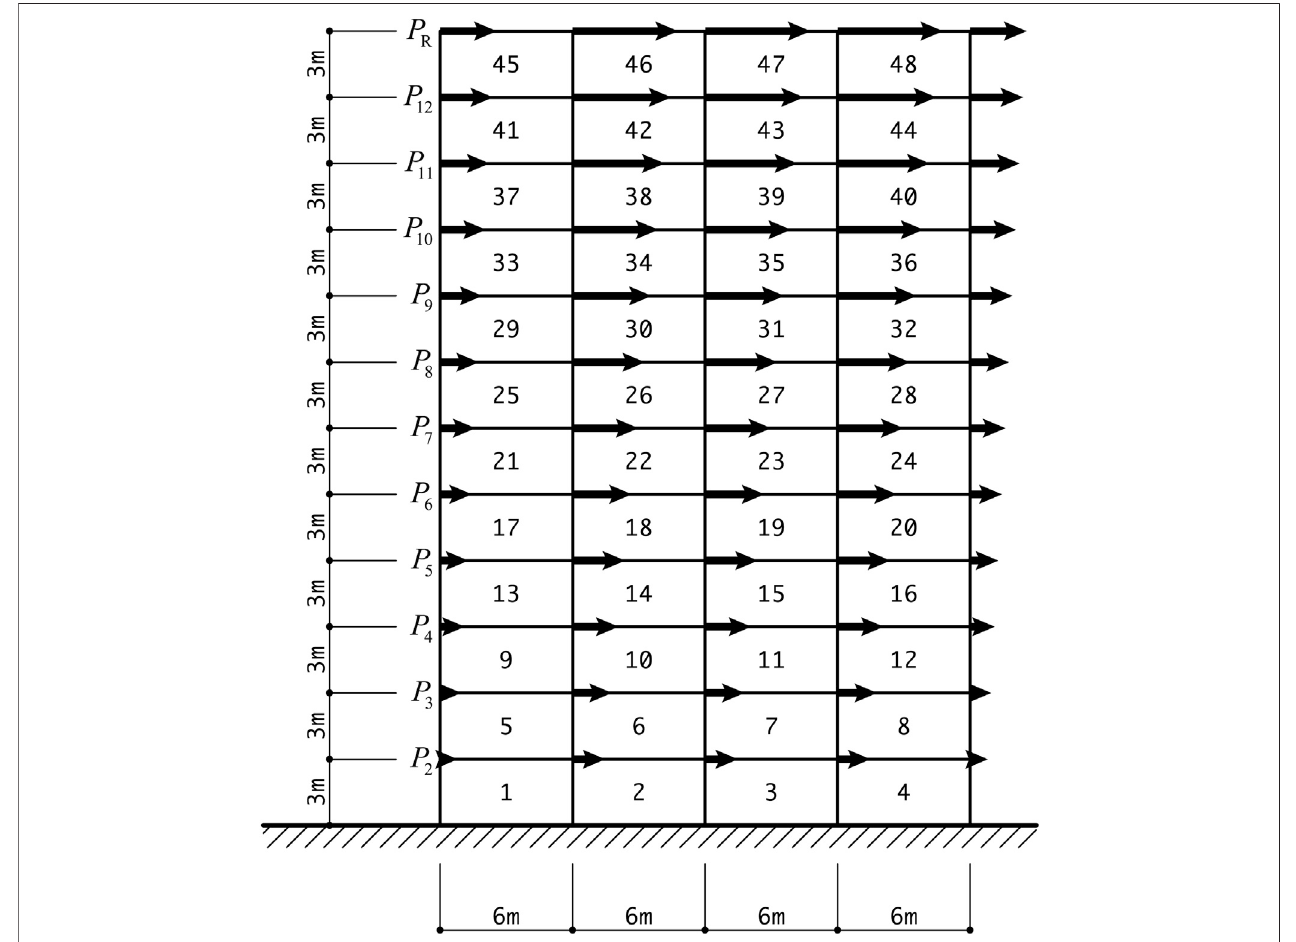
FIGURE 1 | A 12-story 4-span